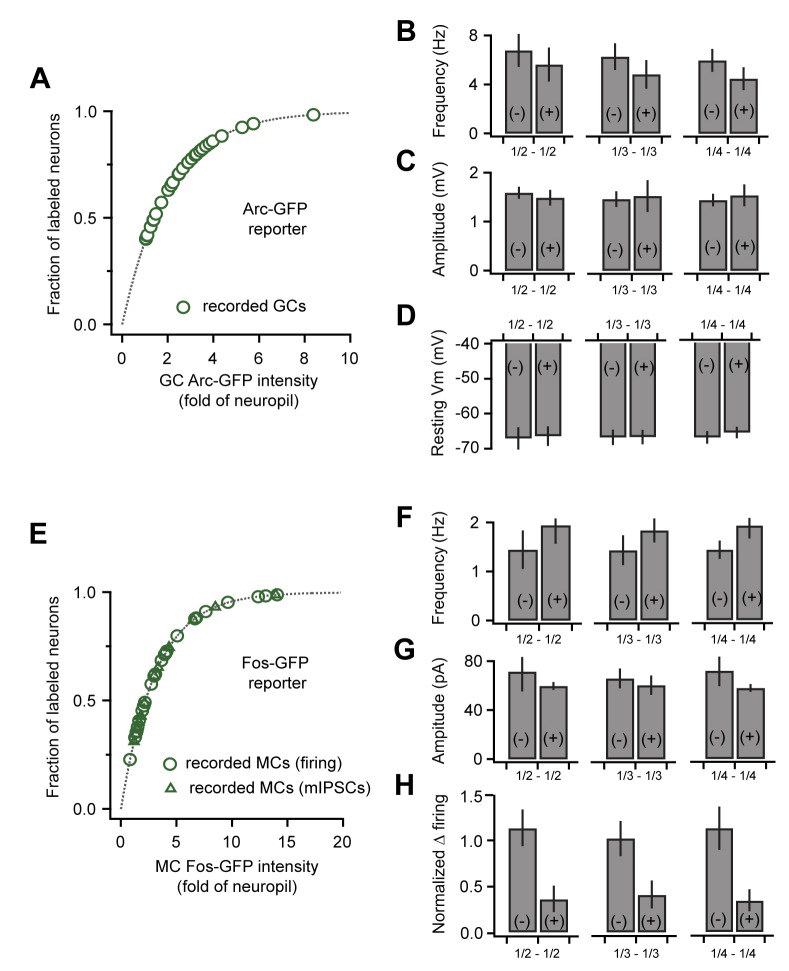
Correlated plasticity and GFP labeling are independent of selection criteria.(A) Arc-GFP labeling intensity for the GCs in our recording sample (green markers) superimposed on the distribution for all detectable GCs (gray line, normalized exponential fit to imaging data). Our dataset spans the majority of intensity values. (B, C, D) Frequency and amplitude of sEPSPs and resting membrane potential of GCs, respectively. Results comparing GFP(+) and GFP(-) populations are consistent across various selection criteria (upper vs. lower 1/2, 1/3, and 1/4 of the recorded cells). (E) Fos-GFP labeling intensity for recorded MCs as in (A). Triangles indicate cells used to analyze synaptic inhibition; circles, cells used to analyze slow firing suppression. (F, G, H) mIPSC frequency, mIPSC amplitude, and firing rate suppression for repetitive stimuli, respectively. Results were again consistent across a range of selection criteria.